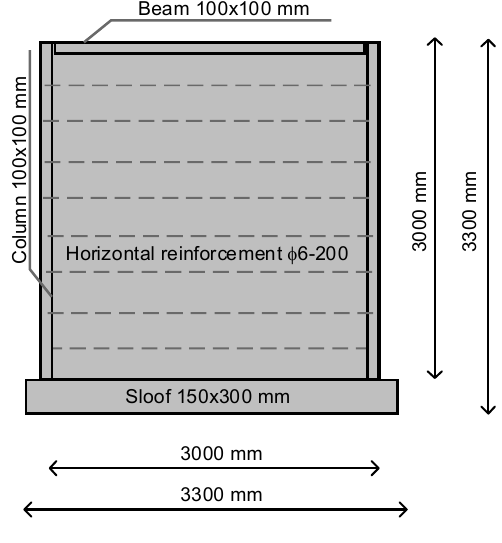
Figure 3. LCWHB-200. Figure 3.